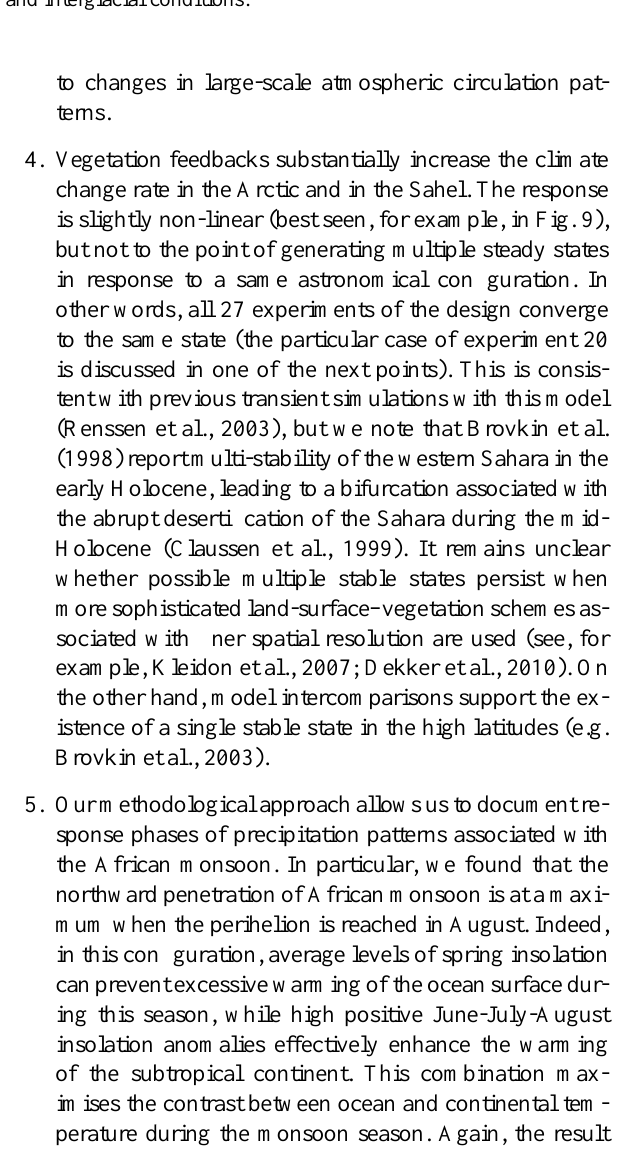
Figure 10. Maximum rate of change, in units per thousand years, estimated using the PC emulator and assuming a quasi-stationary climate and interglacial